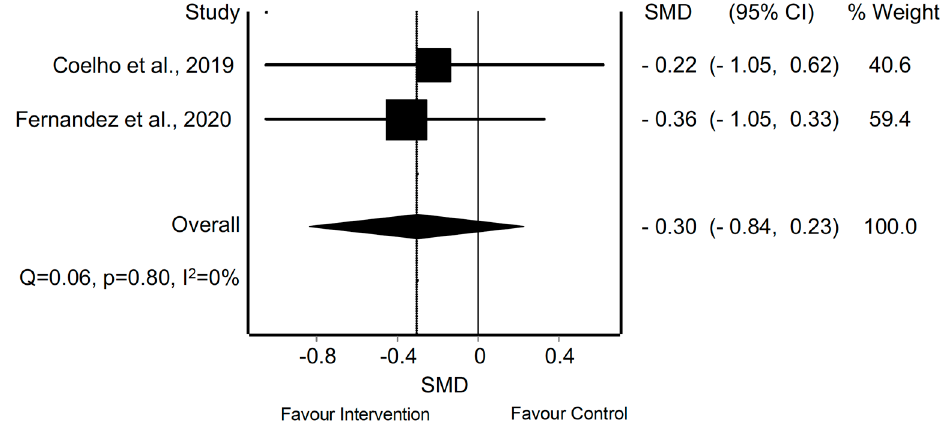
Figure 11. Synthesis forest plot for the frequency of symptoms in patients with cervicogenic headache and mixed intervention. The forest plot summarizes the results of included studies (review size, standardized mean differences [SMDs] and weight). The small boxes with the squares represent the point estimate of the effect size and sample size. The lines on either side of the box represent a 95% confidence interval (CI).